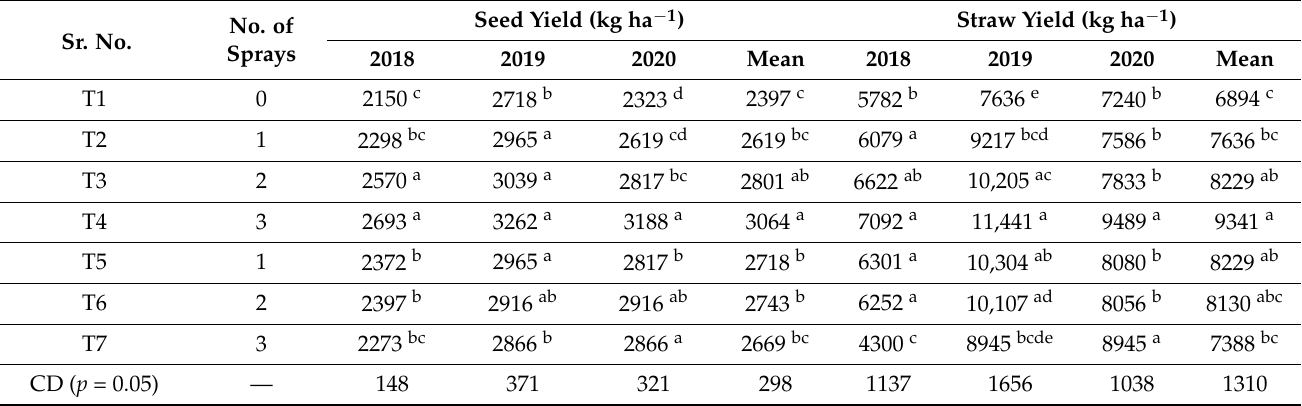
Table 2. Impact of foliar application of FeSO 4 · 7H 2 O on seed and straw yield of soybeans.